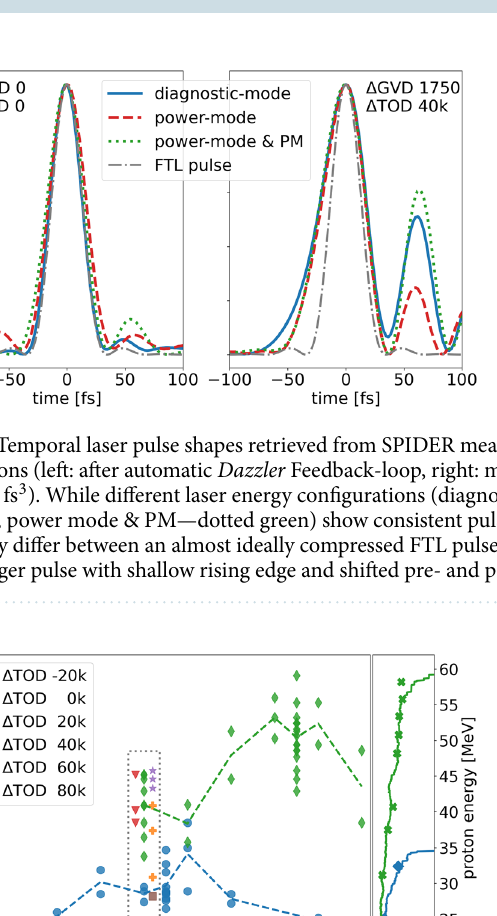
Figure 3. Maximum proton energies from 400 nm Formvar targets for different GVD and TOD Dazzler values and PM cleaned contrast. Each marker represents one single shot, dashed lines connect mean values. While 3 2 the maximum energy for the standard settings ( (cid:31) GVD=0 fs , (cid:31) TOD=0 fs ) is below 30 MeV, the optimized 3 2 conditions (1750 fs , 40k fs ) yield 60 MeV and thus an effective doubling of the maximum energy in this case. The right side plot shows particle numbers from shots with TPS (solid lines) and shots with RCF (individual markers) measurements for the standard (blue) and optimized (green) settings with higher particle numbers in the optimized case